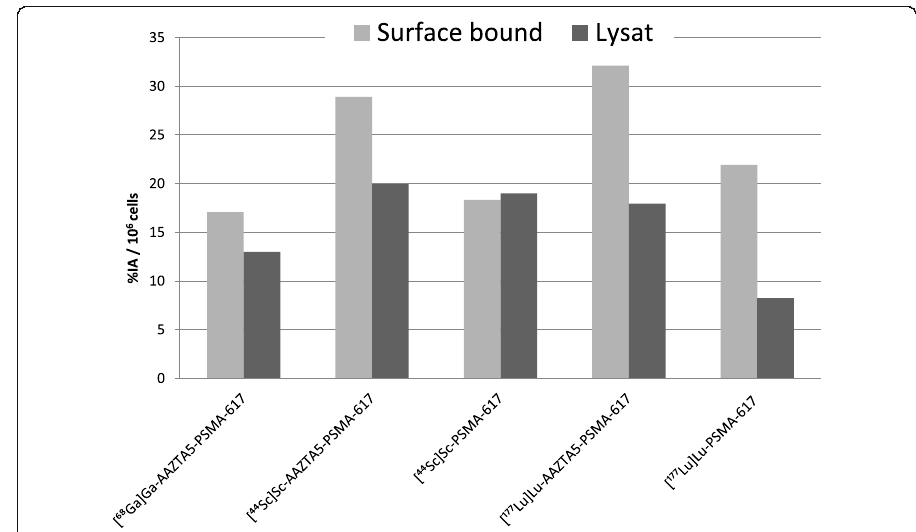
Fig. 3 Internalization data of the 68 Ga, 44 Sc and 177 Lu complexes of AAZTA 5 -PSMA-617 and PSMA-617 in LNCaP cells at 37 °CCheng-Prusov equation with: c dim = concentration of PSMA-10 and K d = dissociation constant of [ 68